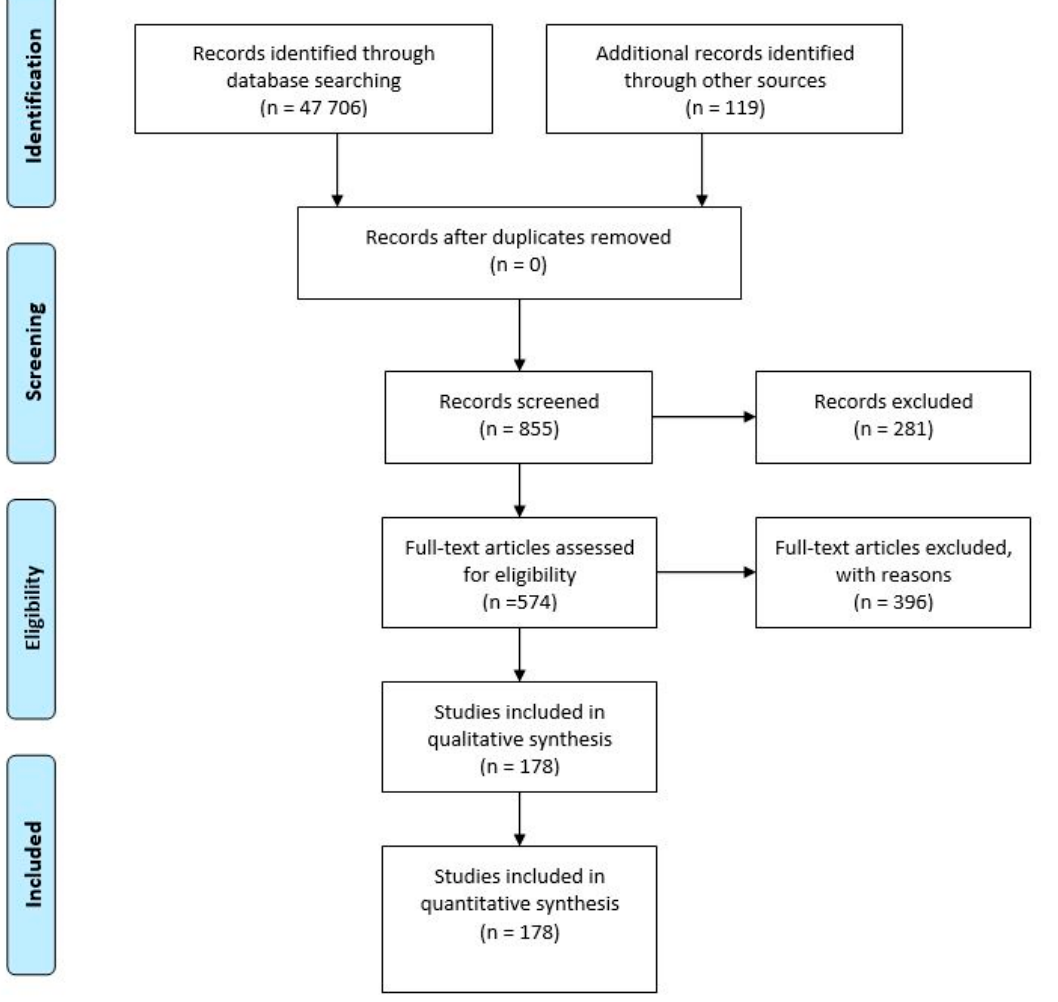
Figure 1. PRISMA flowchart with the global results of the literature review and applied